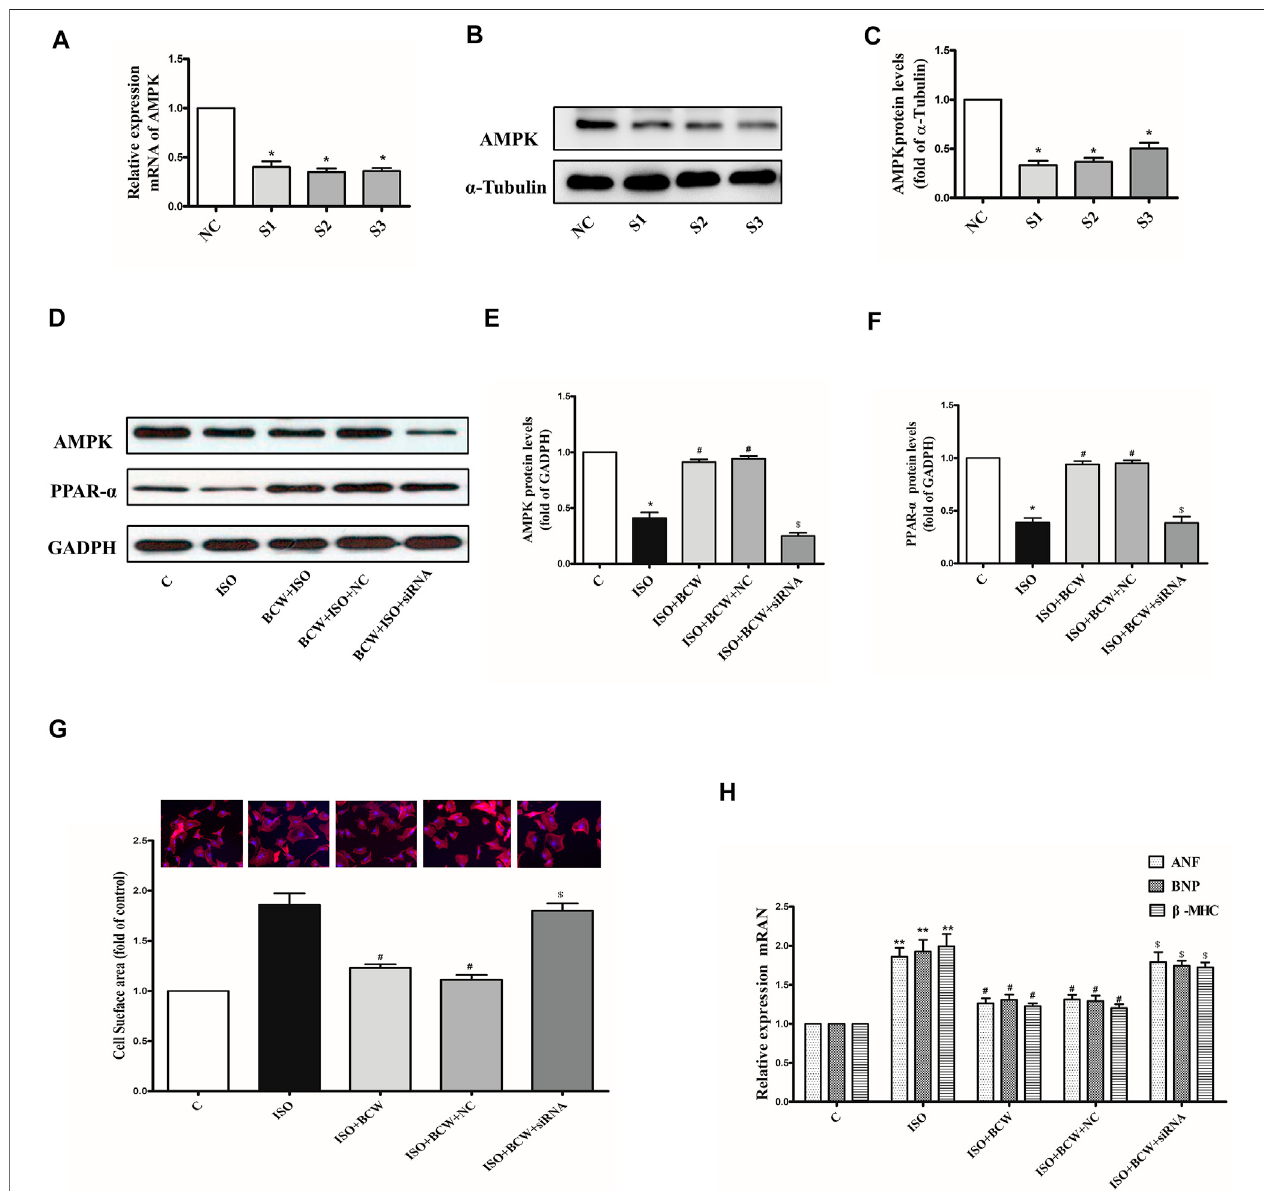
FIGURE8| Adenosine 5 ’ -monophosphate – activated protein kinase (AMPK) silencing the reversed anti-hypertrophy effect ofBCWin neonatalratcardiomyocytes inducedbyISO. (A) mRNAand (B – C) proteinexpression ofAMPKincardiomyocytestransfected withthreedifferentsiRNAsforAMPKornegativecontrol(NC) for48 h. (D – F) Protein expression of AMPK and PPAR- α in primary neonatal rat cardiomyocytes infected with or without AMPK siRNA or the NC for 48 h, or treated with or without 10 μ M ISO for 24 h. (G) Cell surface area measured by rhodamine phalloidin staining (red for rhodamine phalloidin and blue for DAPI) and in primary neonatalratcardiomyocytesinfectedwithorwithoutAMPKsiRNAortheNCfor48 h,ortreatedwithorwithout10 μ MISOfor24 h(observedat200 × magni fi cation). (H) The mRNA expressions of the ANF, BNP , and β -MHC determined by qRT-PCR in primary neonatal rat cardiomyocytes infected with or without AMPK siRNA or the NC for 48 h, ortreated withor without10 μ MISOfor 24 h(observed at 200 × magni fi cation).DatawerenormalizedbyGADPH formRNA expression and protein expression and presented as mean ± SE. * p < 0.05 vs. control; # p < 0.05 vs. ISO, $ p < 0.05 vs. ISO + BCW + NC n (cid:2)